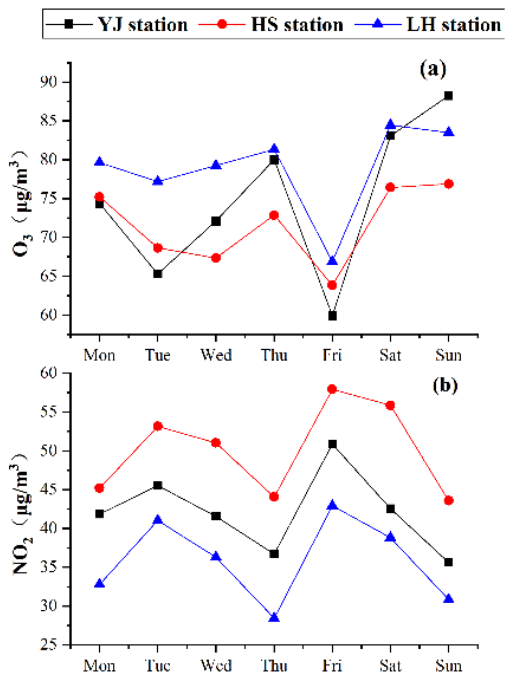
Figure 3. Weekly variation in O 3 ( a ) and NO 2 ( b ) concentrations at the three stations. Differences in the O 3 concentration are observed at the three stations. The highest O 3 concentration was measured at the LH station, followed by the two roadside stations YJ and HS. The reason is the surrounding environment. The LH station is located in Luhu Park. VOCs generated by biological sources compete with NO, reducing the inhibition of